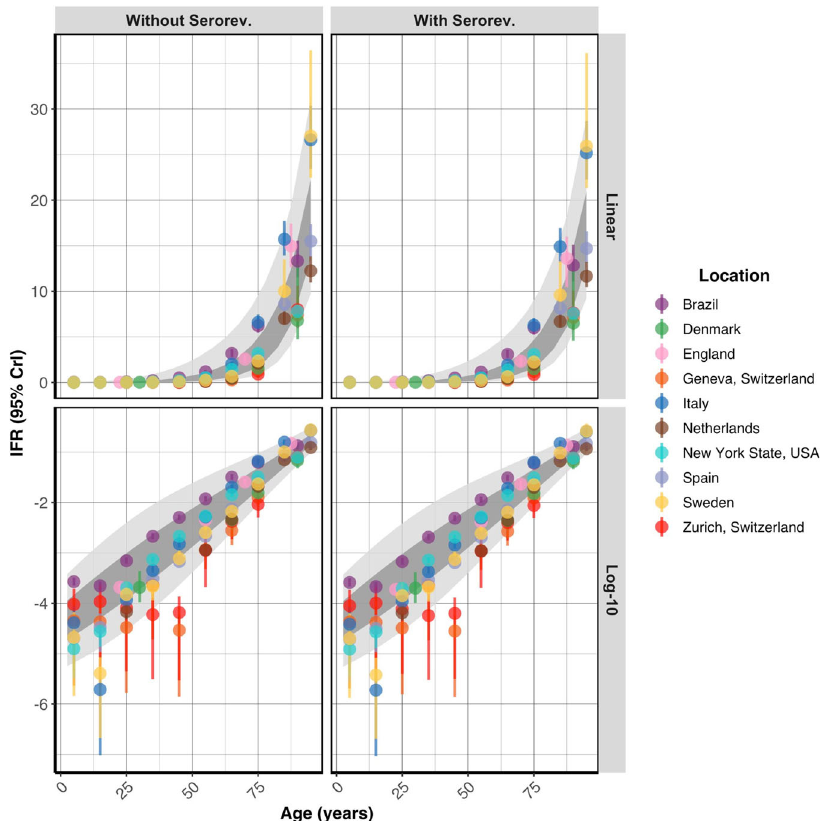
Fig. 7 Age-strati fi ed infection fatality ratio estimate. The age-speci fi c modelled IFR (%) median and 95% credible interval estimates with and without seroreversion are plotted on a linear and log-10 scale (mean age within each age group plotted). The 95% prediction intervals (light grey) and the 80% prediction intervals (dark grey) calculated from the age-speci fi c pooled-IFR estimates are shown for each model. The IFR increases in a log-linear fashion with age.